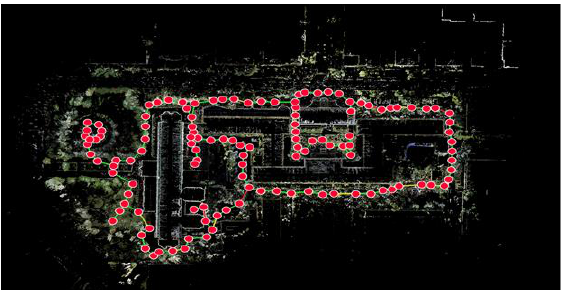
Figure 7. The process of optimizing point cloud groups.